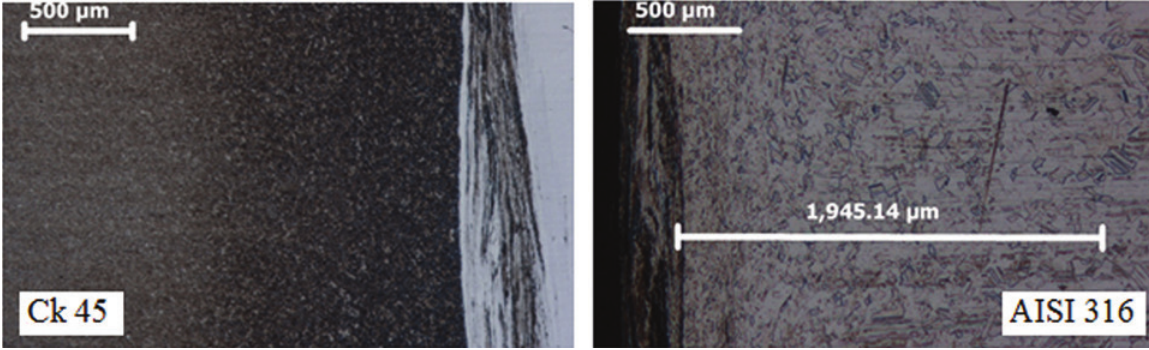
Fig. 4: Optical microstructure of welded Ck 45 and AISI 316 steels of sample 2